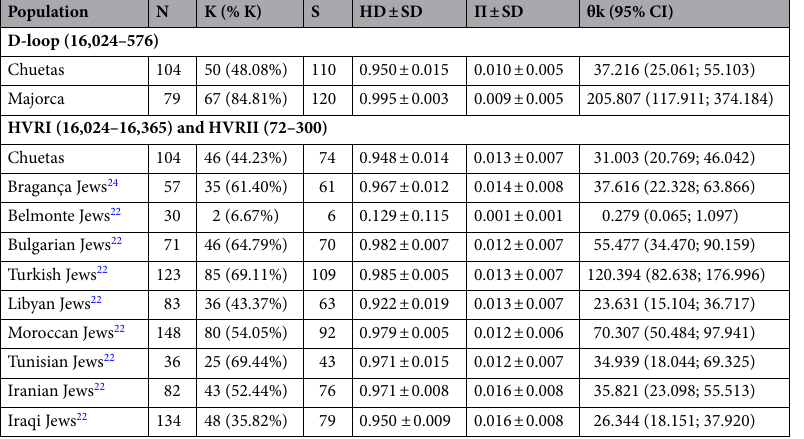
Table 2. Diversity indices results calculated for the complete D-loop and for the HVRI + HVRII fragment for inter-population comparison. K Number of different haplotypes, S number of polymorphic sites, HD haplotype diversity, Π nucleotide diversity averaged over loci, θk theta estimator based on the number of different lineages.